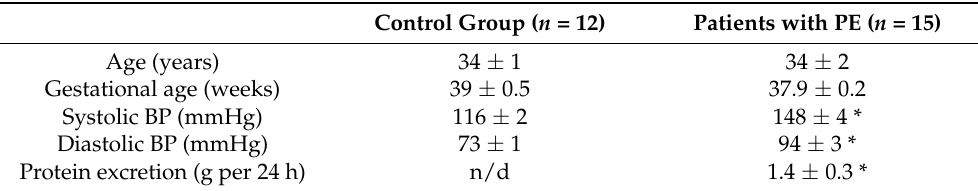
Table 1. Characteristics of the study